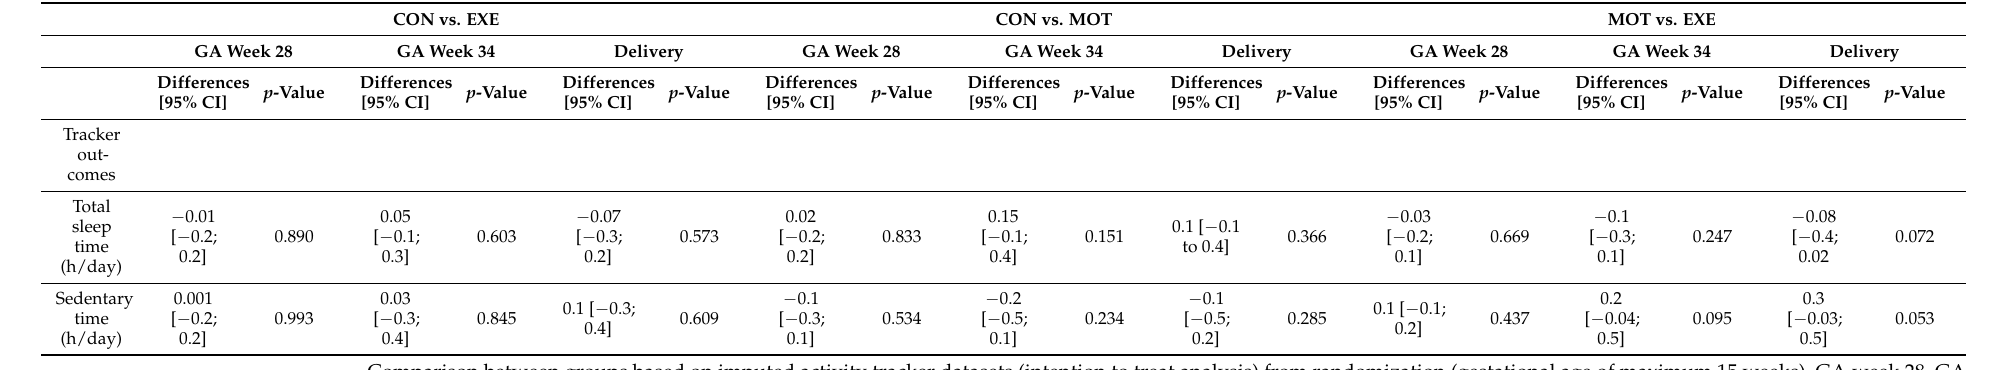
Table 2. Sleep and sedentary time from an activity